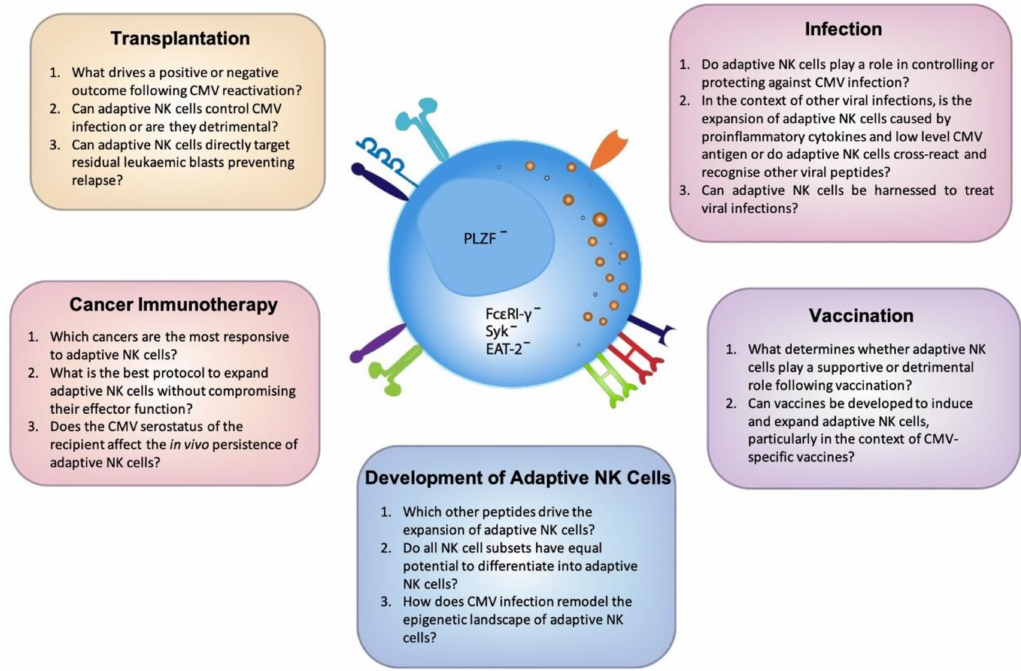
Figure 2. Outstanding questions to unlock the full potential of adaptive NK cells. Cytomegalovirus (CMV) has the unique ability to imprint on the NK cell repertoire resulting in the expansion of diverse, highly functional adaptive NK cells. A greater understanding of the mechanisms that drive the development of these cells is clearly warranted. Here we have identified the most pressing questions across a number of emerging fields which, upon further investigation, will elucidate the maximal clinical potential of adaptive NK